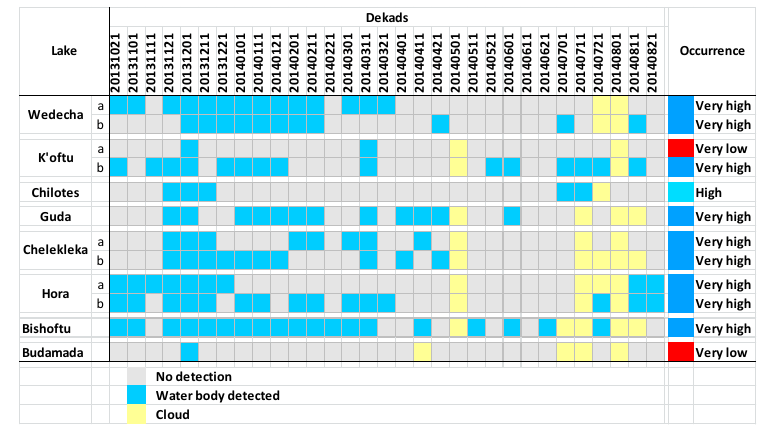
Figure 12. Time series analysis for several small lakes showing the detections per dekad and the resulting WB occurrence. Each row shows the behavior of one pixel of the water body during the 31 dekads starting from 21 October 2013 to 21 August 2014. The blue marked dekads show the dekads where the pixel is detected as WB.